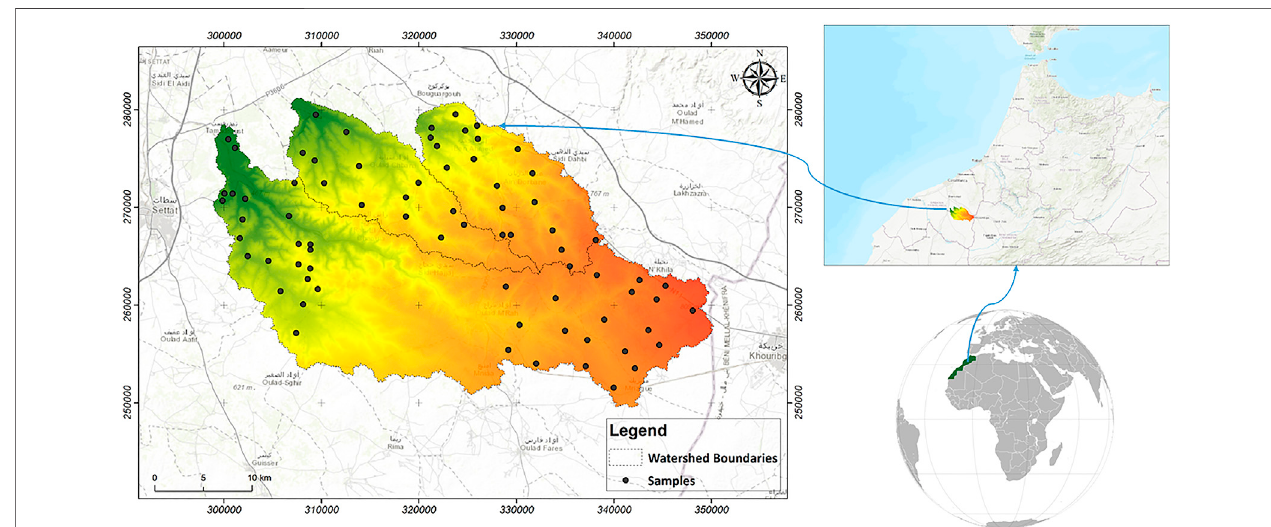
FIGURE 1 | Location of study area and distribution of sample